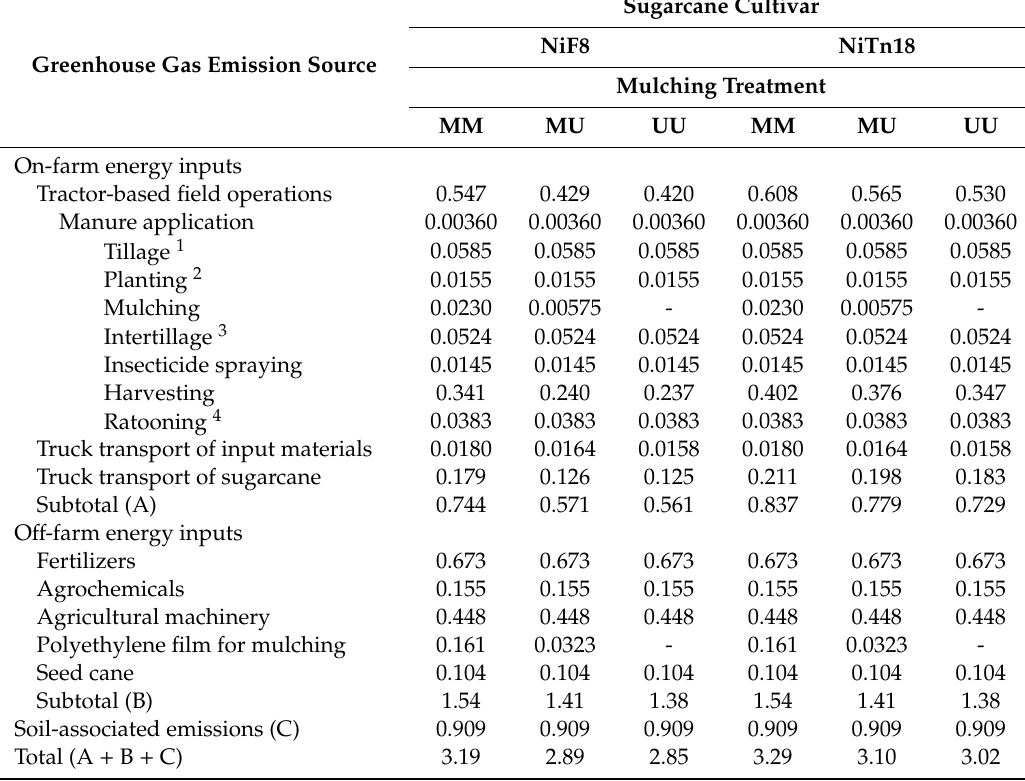
Table 4. Greenhouse gas emissions (Mg CO 2 eq. ha − 1 year − 1 ) estimated for the combined cultivation systems of three polyethylene mulch treatments and two